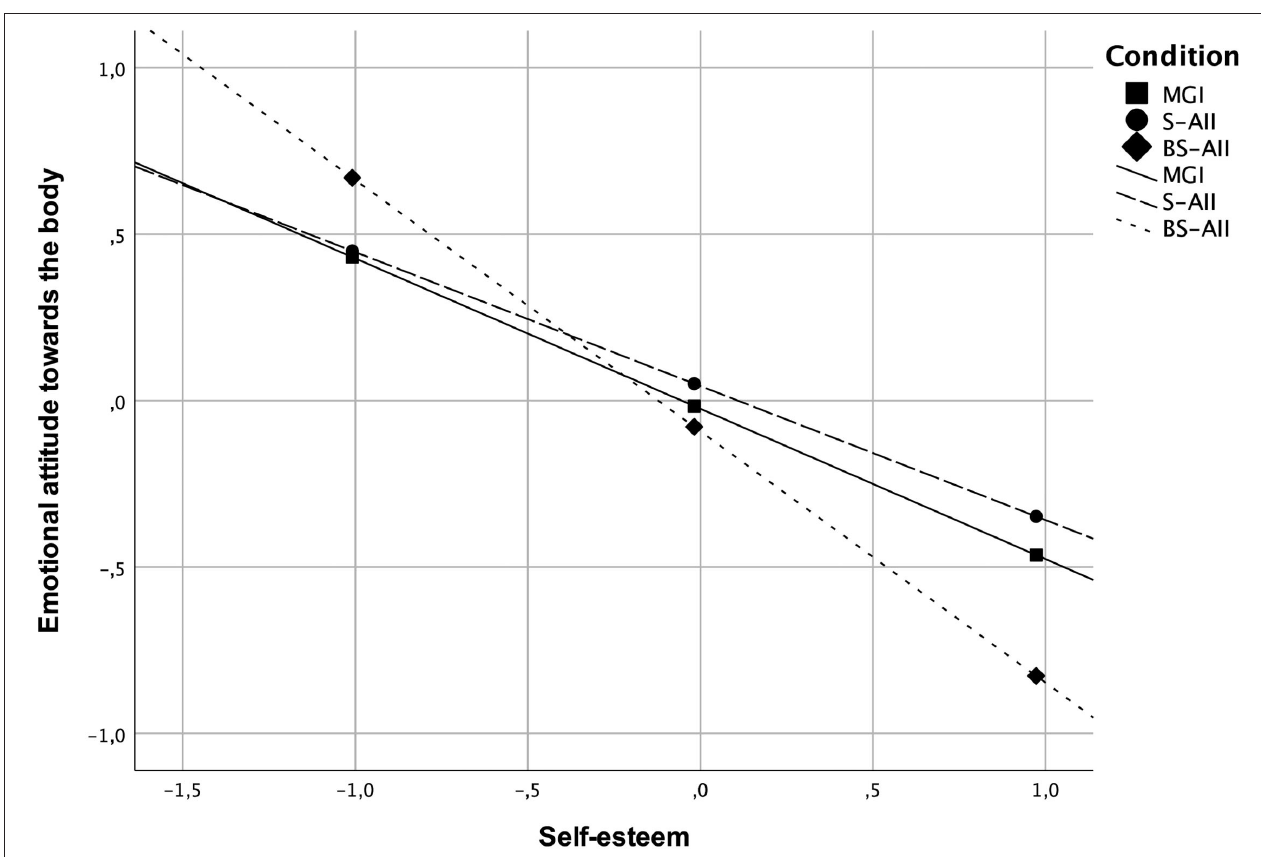
FIGURE 3 | Moderating effects of self-esteem between the group assignment and negative emotional attitude toward the body at post-intervention (T2). Both the x - and y -axis represent standardized